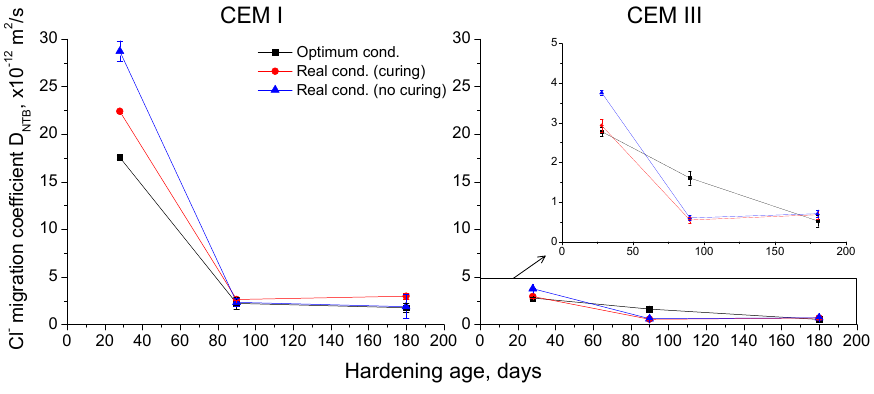
Figure 9. Results of non-steady-state chloride migration coefficient for concretes prepared using CEM I and CEM III, respectively.